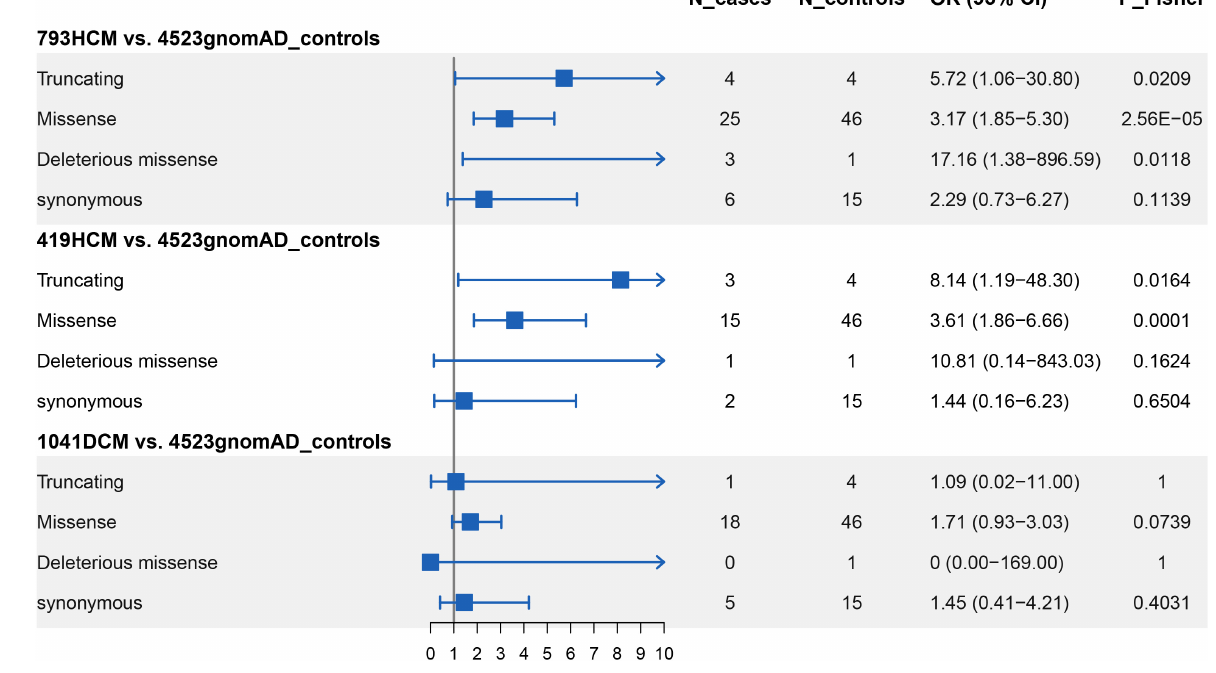
FIGURE 2 | Gene-based burden tests for rare variants in ALPK3 . N_cases: number of carries in cases; N_controls: number of carries in controls; OR: odds ratio; 95% CI: 95% confidence